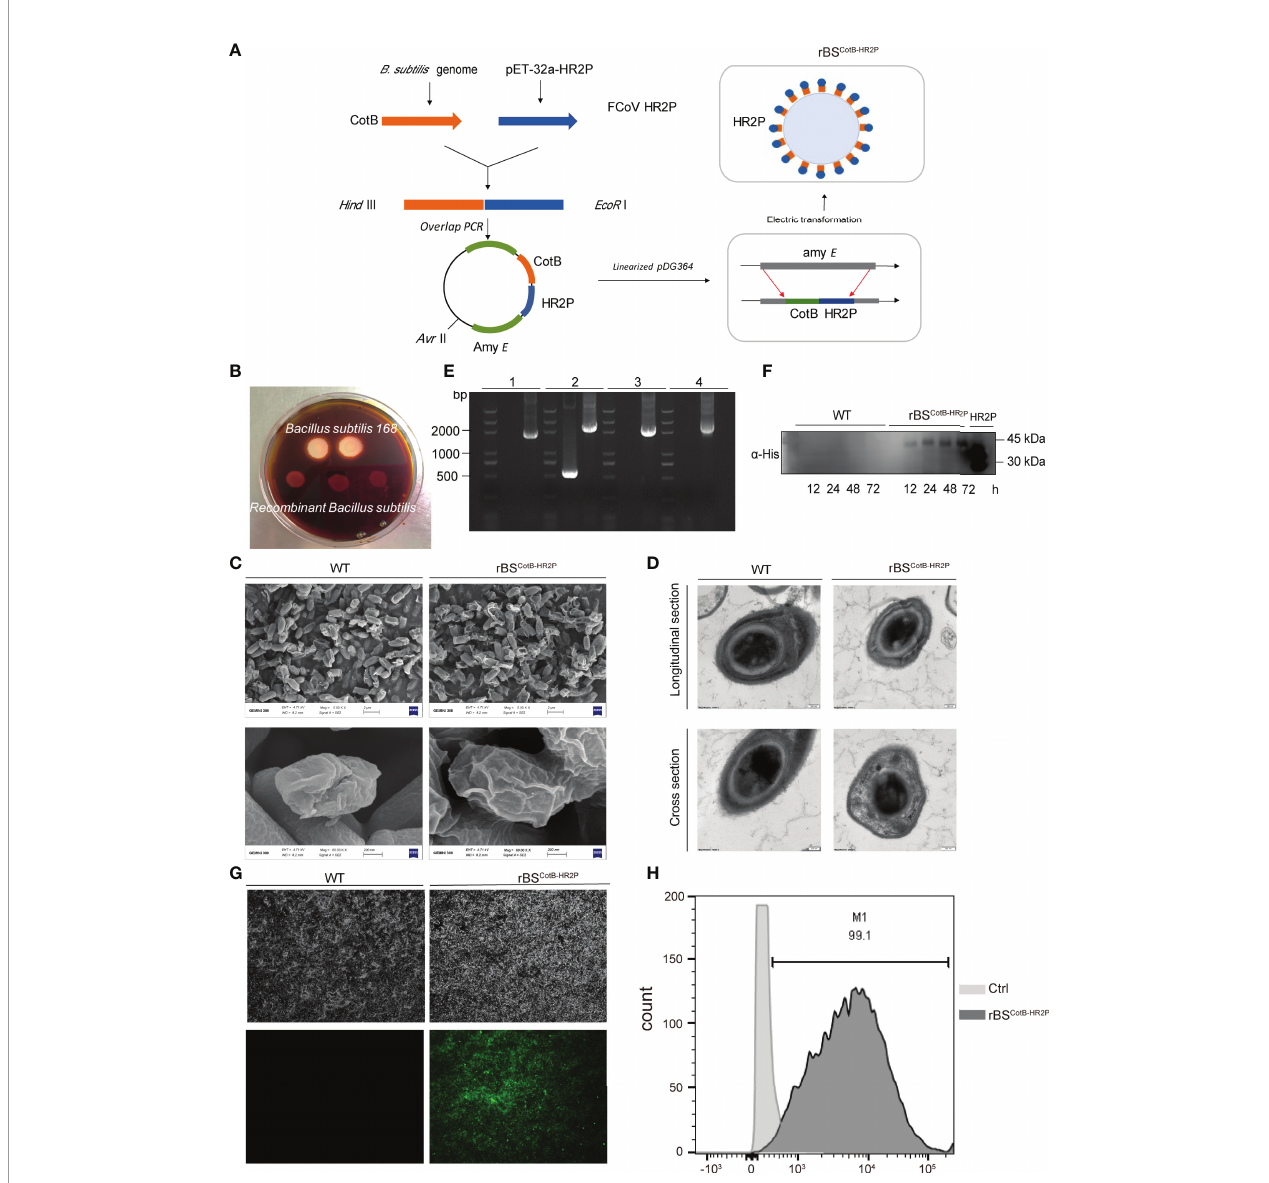
FIGURE 2 | Construction of recombinant B. subtilis with surface display of FECV HR2P. (A) Genetic engineering of a recombinant B. subtilis spore with CotB-HR2P on its surface (rBS CoTB-HR2P ). (B) Starch hydrolysis test. B. subtilis 168 and rBS CoTB-HR2P were cultivated on a medium containing 1% starch and stained with iodine. (C) Images of WT and RBS CotB-HR2P spores obtained by scanning electron microscopy; scale bars: 2 m m (upper); 200 nm (lower). (D) Images of WT and rBS CotB-HR2P spores were obtained by transmission electron microscopy; scale bars: 200 nm. (E) PCR analysis of B. subtilis using different primer pairs: (1) CotB-F and HR2P-R; (2) amyE-F and amyE-R; (3) amyE-F and HR2P-R; and (4) CotB-F and amyE-R. (F) Western blot detection of the CotB-HR2P fusion protein from wild-type (WT) and rBS CotB-HR2P spores induced by DSM at different time points (12, 24, 48, and 72 h), probed with polyclonal mouse anti-His antibody. (G) Immuno fl uorescence of CotB- HR2P on the spore surface at 72 h after induction of wild-type (WT) and RBS CotB-HR2P . (H) Flow cytometry analysis of CotB-HR2P fusion protein expressed on the surfaces of WT and rBS CotB-HR2P